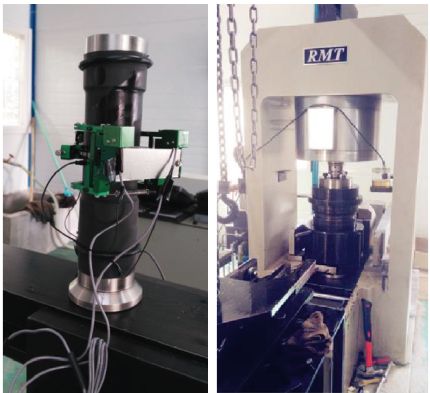
Figure 3: Photographs of the servo-controlled